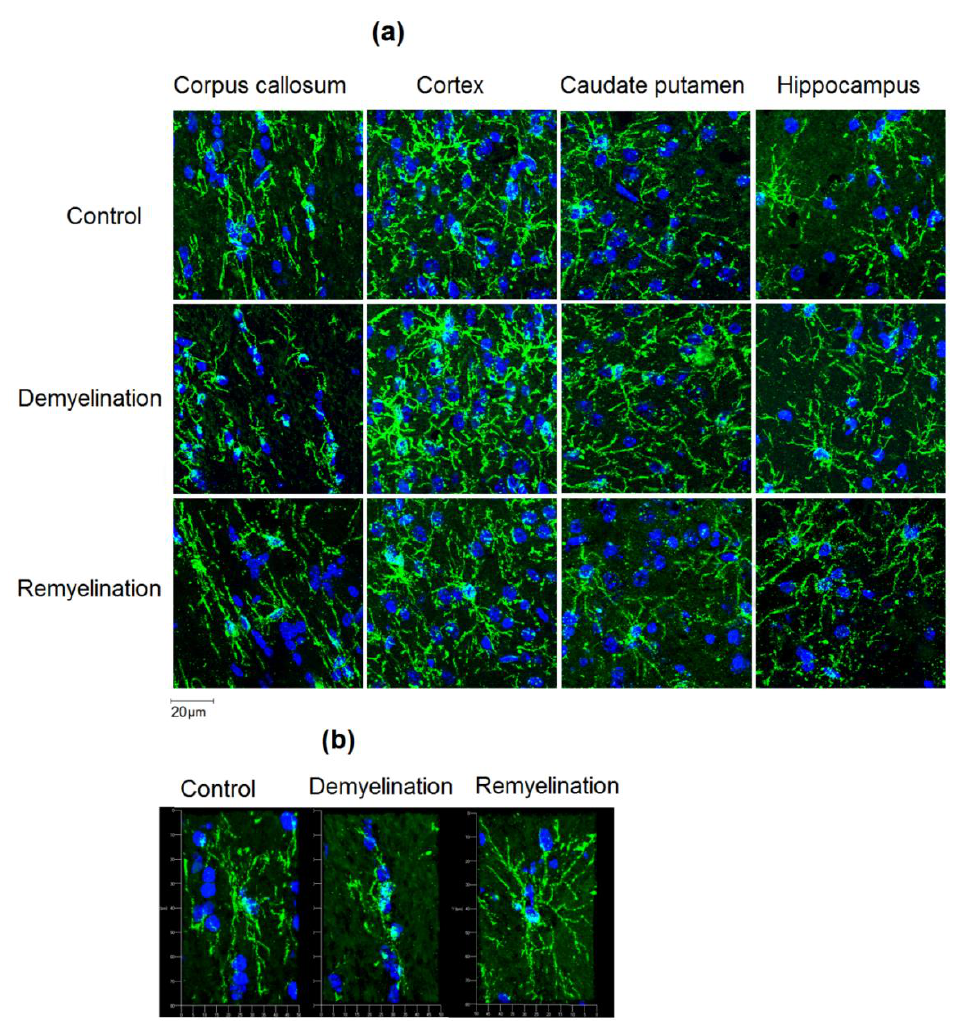
Figure 5. E ff ect of cuprizone-induced demyelination and remyelination after cuprizone discontinuation on the amount of OPC (NG2-positive cells). ( a ) Example microphotographs of NG2-stained sections corresponding to the corpus callosum, caudate putamen, cortex, and hippocampus with magnification of × 200. ( b ) 3D reconstructions of separate NG2-positive cells in the corpus callosum illustrating distinctions in OPC morphology. Magnification: ×200.